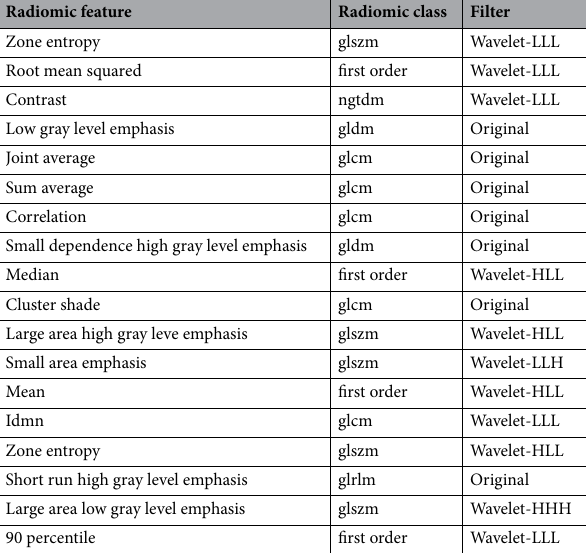
Table 3. Target image histology features and their feature classes and filters based on the SVM classifier model with the VOI sketching method. GLSZM = Gray-Level Size Zone Matrix; GLRLM = Gray-Level Run Length Matrix; GLCM = Gray-Level Co-occurrence Matrix; GLDM = Gray Level Dependence Matrix; NGTDM = Neighbouring Gray Tone Difference Matrix; VOI = volume of